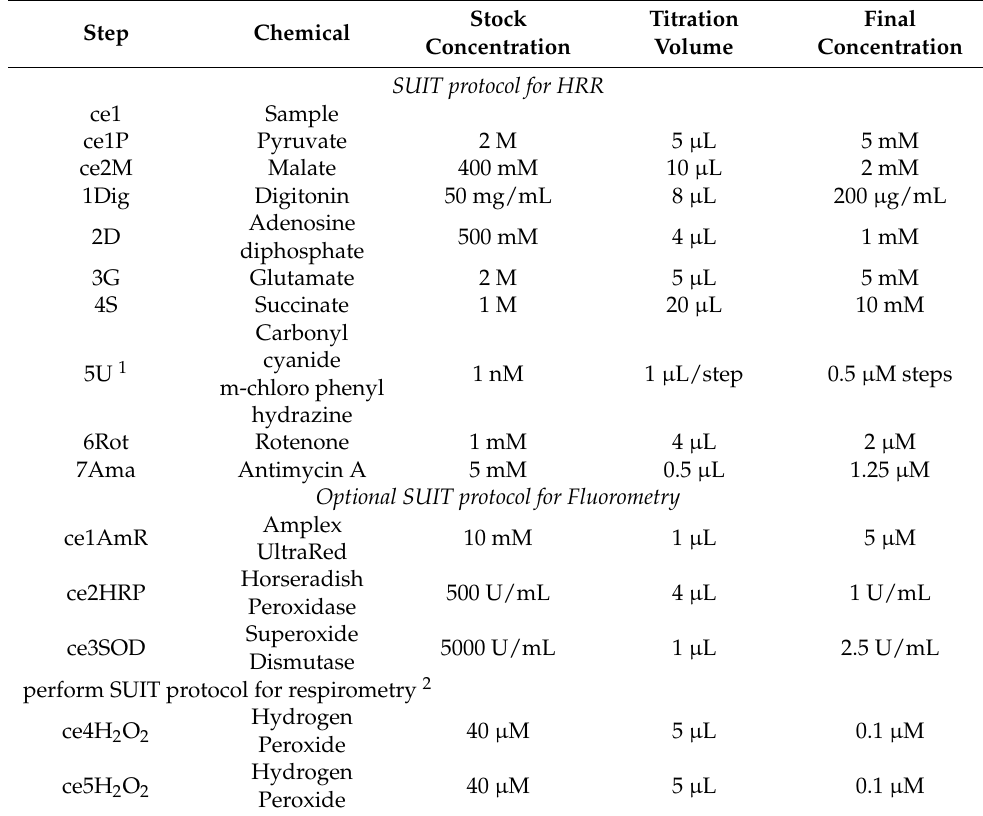
Table 3. Chemicals and SUIT-protocol for O2k FluoRespirometry with LED-2-modules based on the experimental SUIT 8